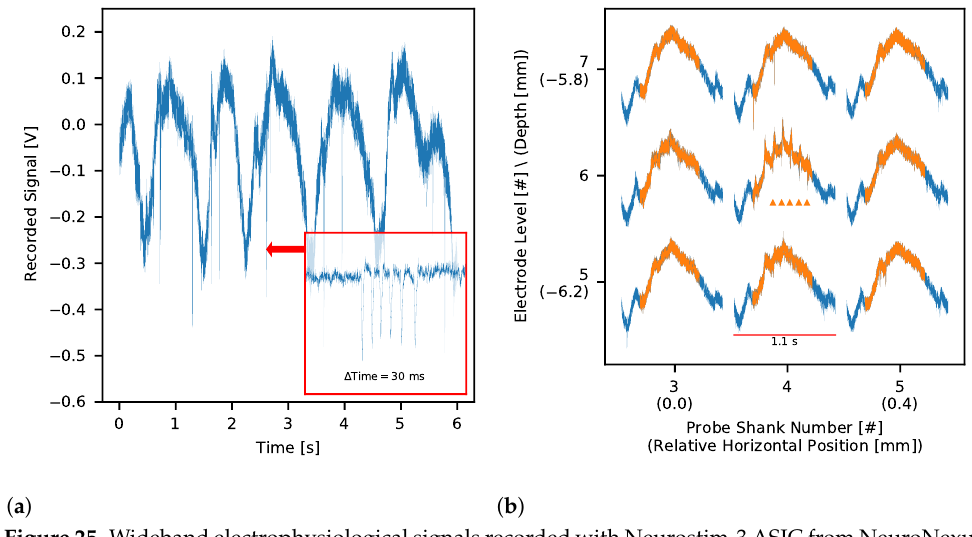
Figure 25. Wideband electrophysiological signals recorded with Neurostim-3 ASIC from NeuroNexus MEA placed in the thalamus of anaesthetized rats. Examples show Local Field Potential (LFP) typical for deep sleep. ( a ) Data from one channel showing large amplitude, slow waves and clear single unit bursting spiking activity. ( b ) Nine neighbouring channels with a slow wave and a sleep spindle—note ∼ 12Hz oscillations in LFP (highlighted parts of waveforms) with bursts of multi-unit spiking activity (arrowhead markers). Traces are drawn without gain correction of potential values.